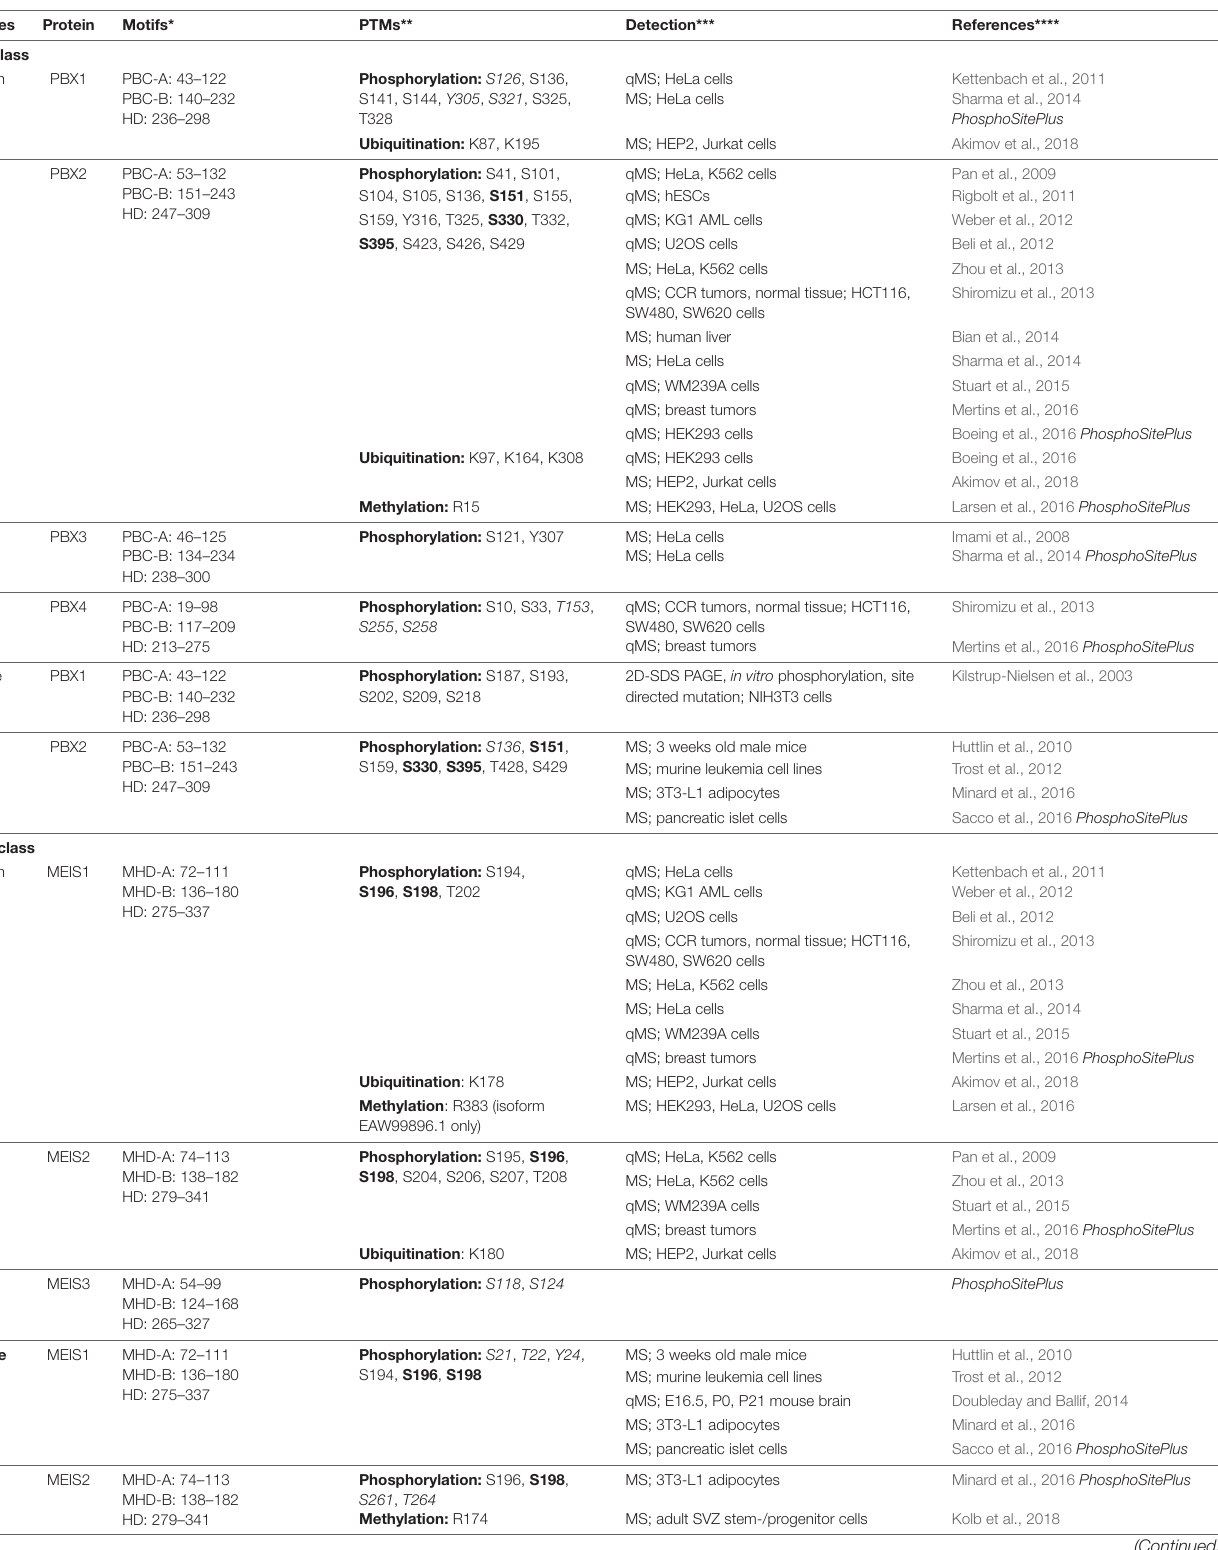
TABLE 1 | Summary of post-translational modifications of TALE-HD proteins.